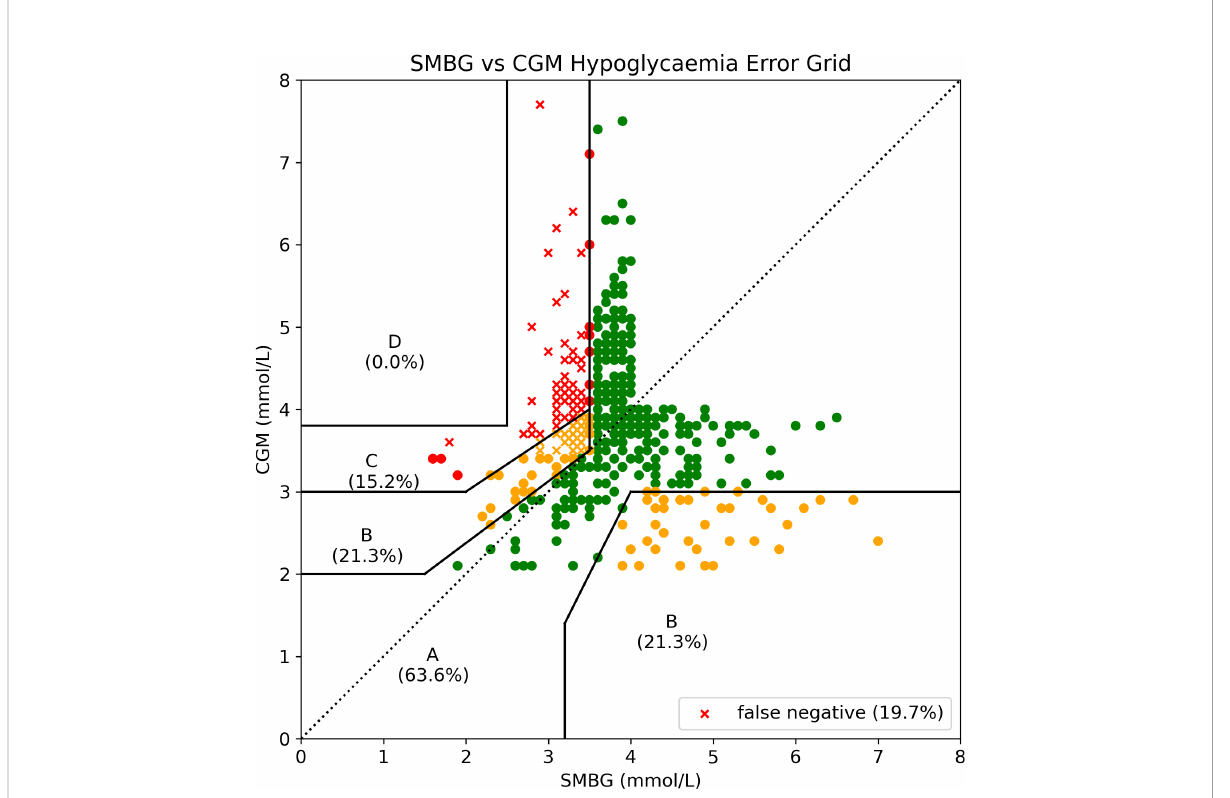
FIGURE 7 Hypoglycaemia Error Grid plotted with paired values restricted to those in which at least one value was <4mmol/L. It is possible to immediately appreciate the increase in values categorised as slight to moderate risk when the dataset is restricted to that of interest to a patient living with